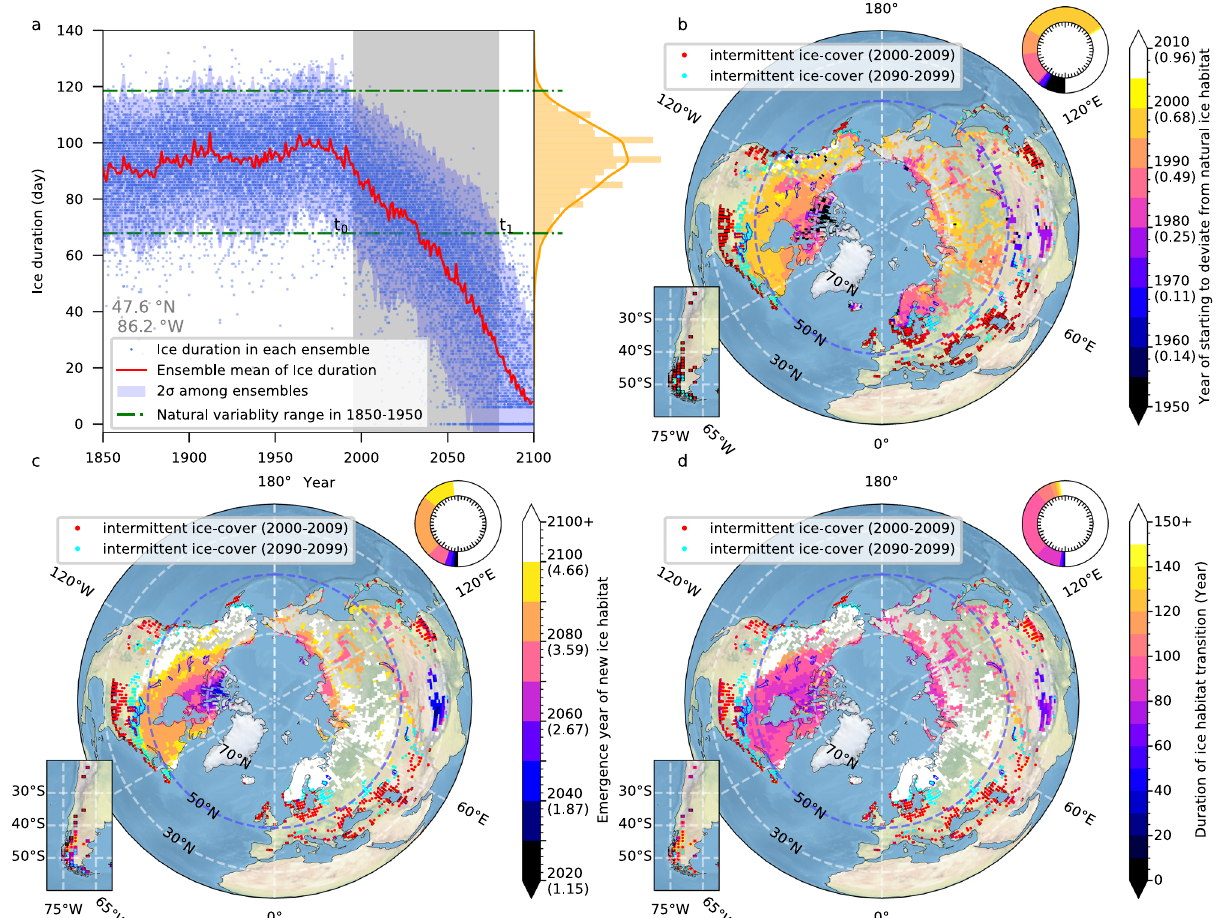
μ +2 σ crossingthelowerlimitofthenaturalvariabilityrange).Thewidthofthegray box represents the maximum adaptation time ( t 1 – t 0 ) for species to adapt to no- analoglakeiceconditionsintermsoficeduration. b Spatialdistributionoftheyear when ice duration starts to deviate from the range of natural variability. Values in the brackets of the color scale are the global mean surface air temperature anomalies of the corresponding years relative to the climatological mean of 1850 – 1950. The relationship between time and global mean temperature anomaly is illustrated in Supplementary Fig. S6. c Spatial distribution of the year when ice duration completely deviates from the range of natural variability, that is, the emergence year of no-analog lake ice habitat. Values in the brackets are also the global mean surface air temperature anomalies as in ( b ). d Spatial distribution of transition time for species to adapt to the new habitat (or migrate poleward, if